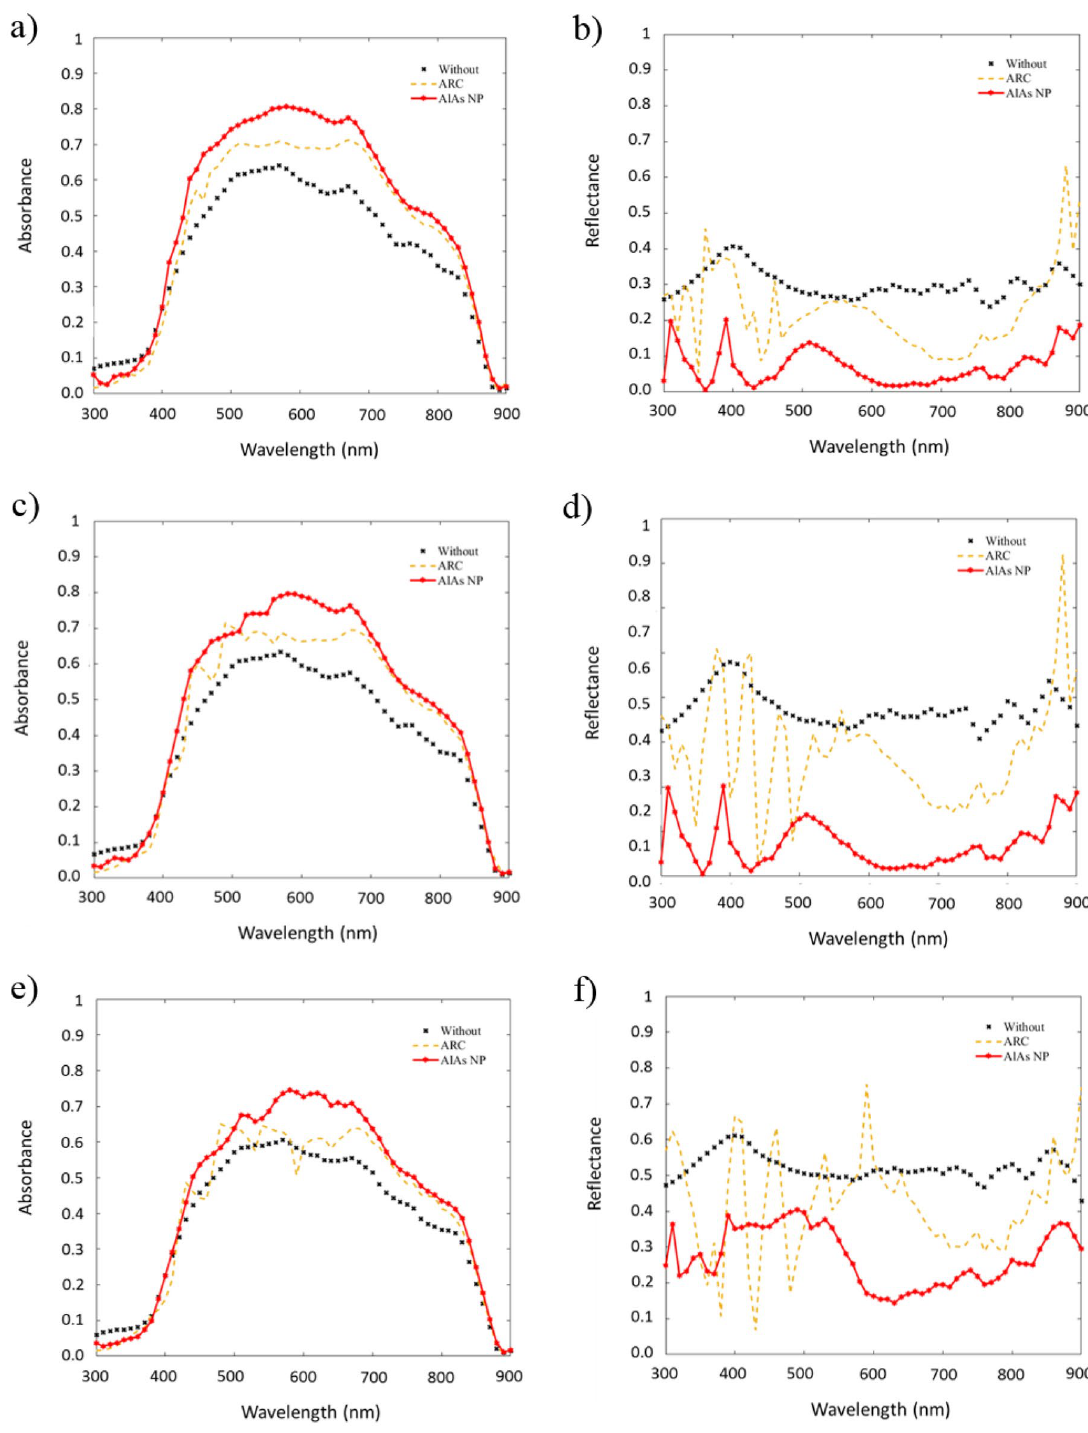
Figure 3. Absorbance in active layer (left) and total reflectance (right) of the device under an incidence of 20° in ( a , b ), of 40° in ( c , d ) and of 60° in ( e , f